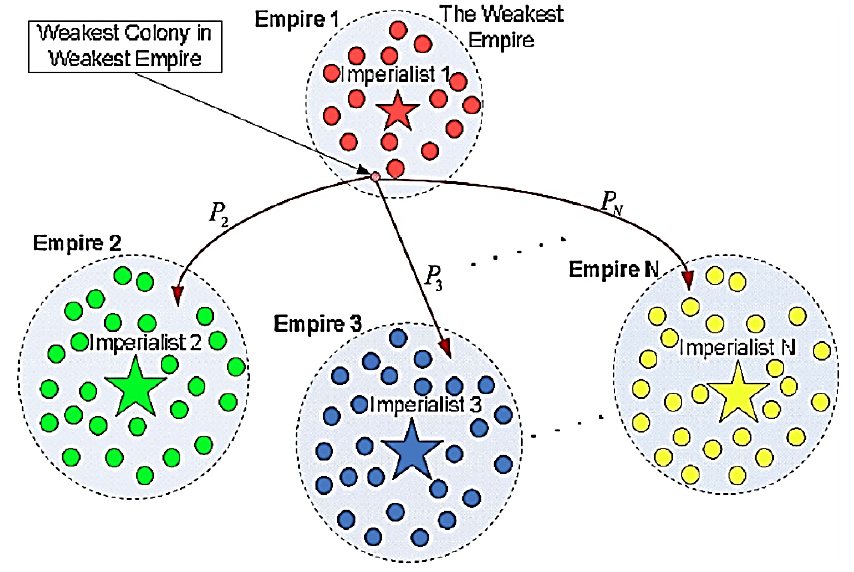
Figure 4. Imperialist competition algorithm main procedure to take possession of a weaker colony.